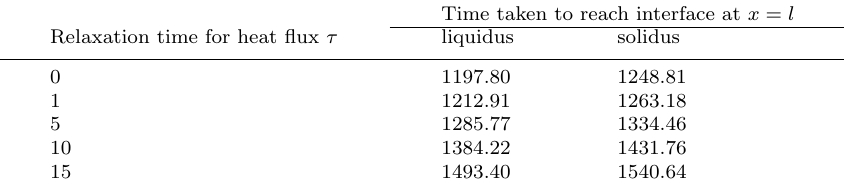
Time taken to reach interface at x = l